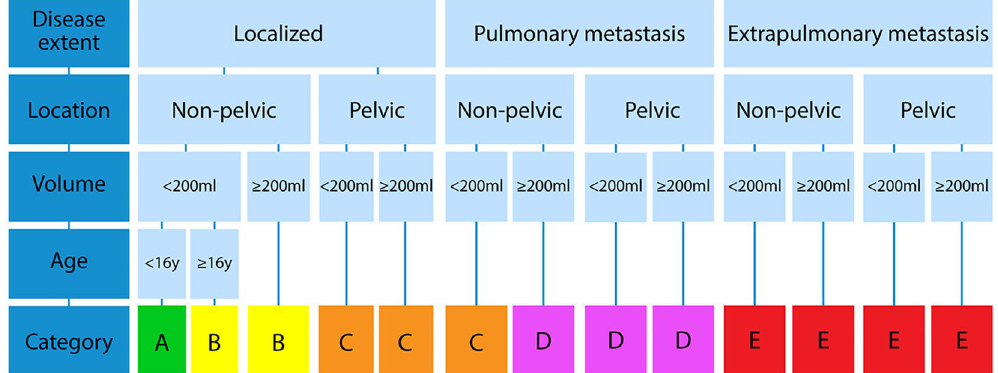
Figure 2. Flowchart for stratification of Ewing sarcoma patients at diagnosis.